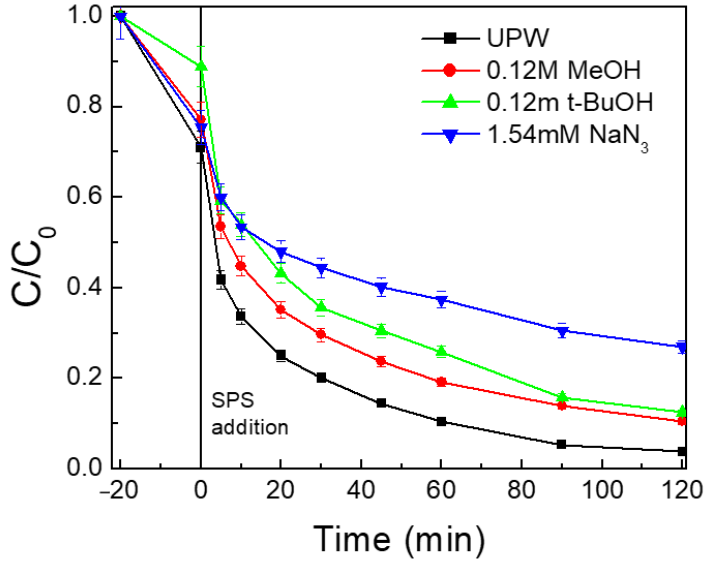
Figure 15. Effect of alcohols and sodium azide on 500 µ g/L SMX degradation with 100 mg/L biochar (RHB 850) and 500 mg/L SPS in UPW and inherent pH.